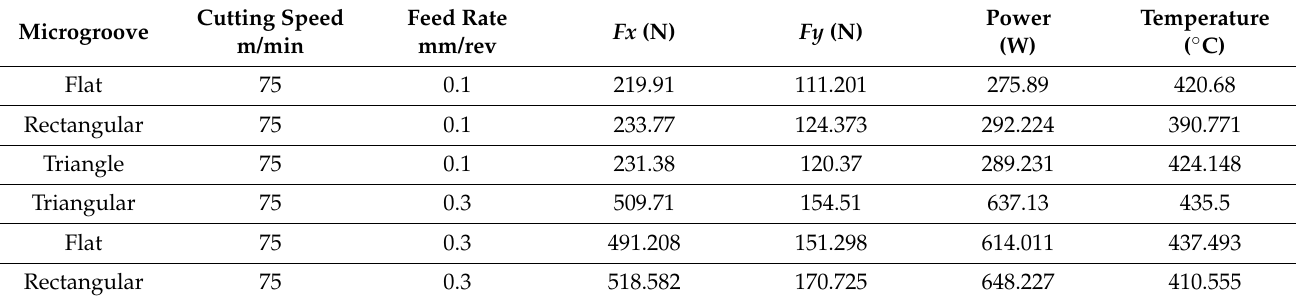
Table 12. Analysis of cutting parameters at different feed rate but constant cutting